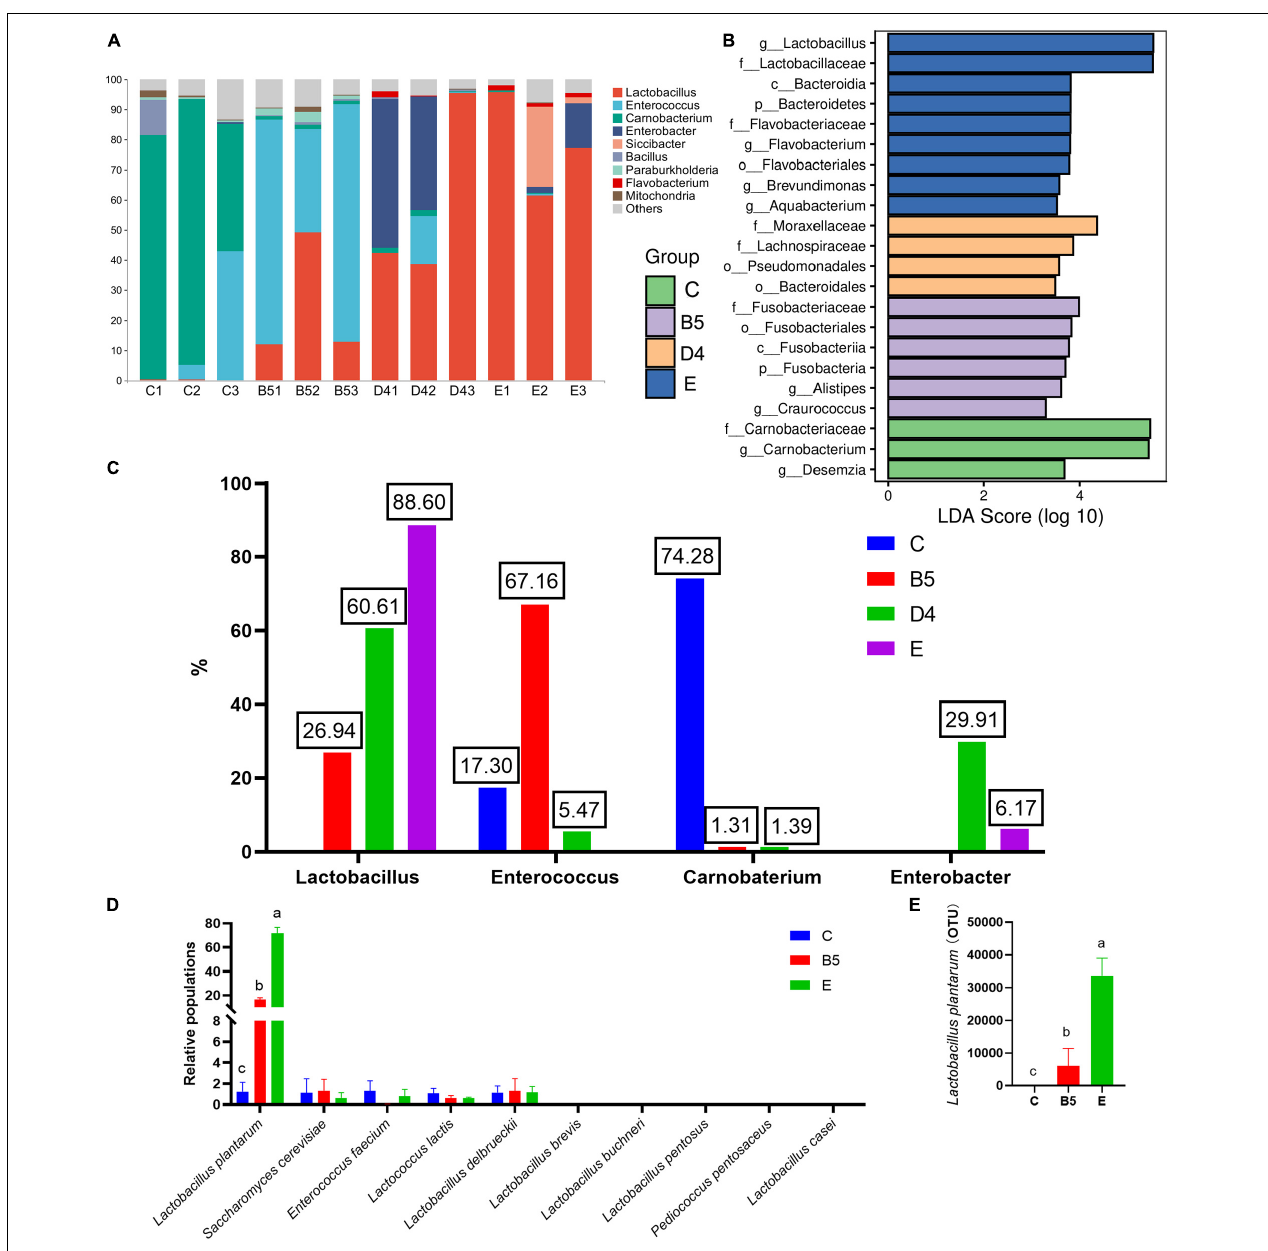
FIGURE 5 | Relative abundances of microbial communities at the genus level (A) , comparison of microbial variations (B) , percentages of main bacteria in A (C) , populations of individual species of lactic acid bacteria by relative quantification PCR (D) and 16 s sequencing (E) among groups of trial 3